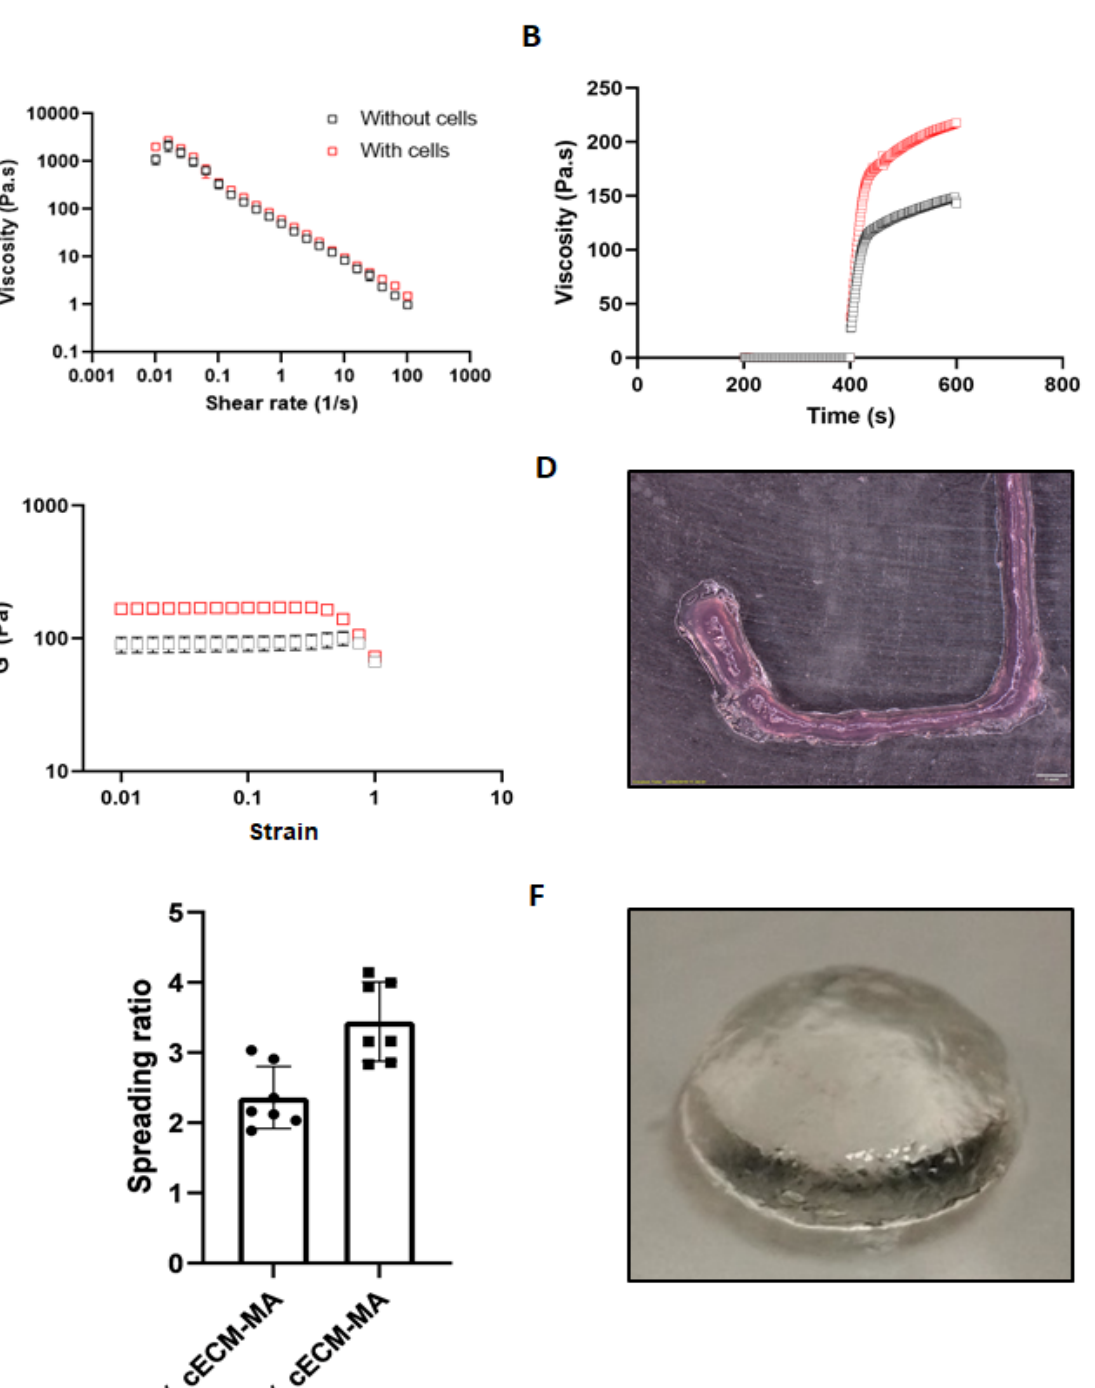
Figure 4. ( A – C ) Rheological properties of cell-laden, gelatin-supplemented cECM-MA bioinks versus acellular controls ( n = 3). ( D ) Microextrusion of acellular 2% cECM-MA bioink. ( E ) Spreading ratio of acellular cECM-MA bioinks printed through 22G needle. ( F ) Printed acellular cylinder of 2% cECM-MA.